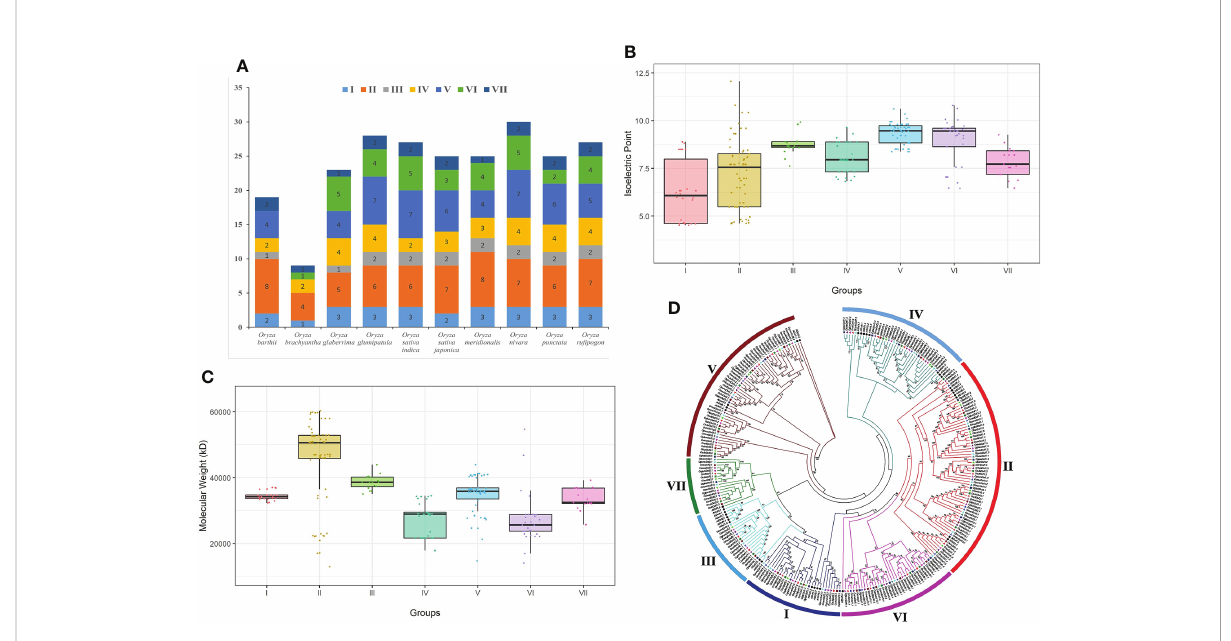
FIGURE 2 Classi fi cation and distribution of Dof genes among ten Oryza genomes. (A) Distribution of Dof genes in ten Oryza genomes. Each bar represents an individual genome with values on top of bars indicating the total number of Dof genes in that genome. (B) Distribution of iso- electric points and (C) molecular weights of Dof proteins belonging to different subgroups, respectively. (D) Comparative maximum likelihood phylogenetic tree of Arabidopsis and Oryza species Dof genes inferred with IQ Tree software (Nguyen et al., 2015) after MAFFT alignment (Katoh et al., 2018) of amino acid sequences. Dof subgroups are indicated with different colors. Arabidopsis Dof genes are labeled with solid black circles, whereas Oryza species Dof genes are labeled with species-speci fi c triangles of different colors. Bootstrap values ( ≥ 50%) as calculated from 1,000 replicates are displayed at tree